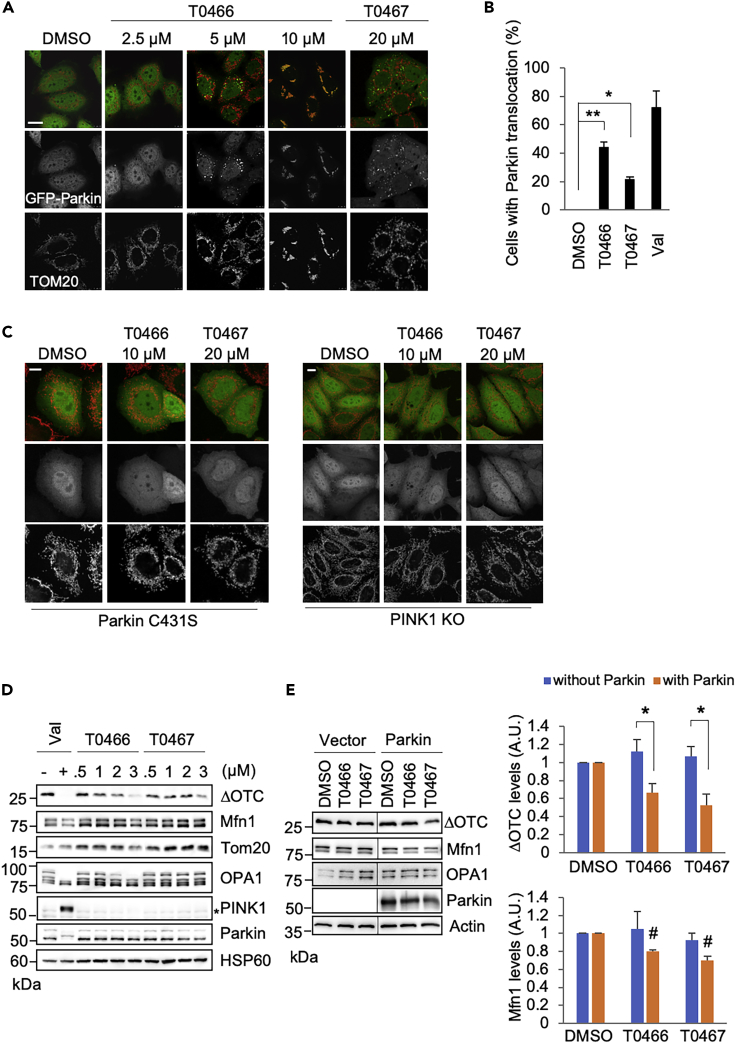
T0466 and T0467 Activate Parkin, Which Reduces an Unfolded Mitochondrial Protein(A) T0466 and T0467 stimulate mitochondrial translocation of Parkin in HeLa cells. HeLa/GFP-Parkin cells were treated with the cpds at the indicated concentrations for 3 h. DMSO treatment served as a mock control. Mitochondria were visualized with anti-TOM20 staining. Scale bar, 20 μm.(B) Mitochondrial translocation efficiency of Parkin by the cpds. HeLa/GFP-Parkin cells were treated with 5 μM T0466 and 20 μM T0467 for 3 h. The graph (mean ± SEM, n = 3 biological replicates) represents the percentage of cells with GFP-Parkin colocalized with TOM20. Cells treated with a mitochondrial uncoupling reagent Val (10 μM) served as the positive control. ∗p < 0.005, ∗∗p < 0.0001 versus DMSO using Dunnett's test.(C) Parkin mitochondrial translocation by T0466 and T0467 is Parkin E3 activity- and PINK1-dependent. HeLa cells transfected with an E3 dead form of GFP-Parkin C431S (left) and PINK1-deficient HeLa cells (right, PINK1 KO) were treated with T0466 or T0467 as in (A). Scale bars, 25 μm.(D) Unfolded mitochondrial protein (ΔOTC) is reduced by T0466 and T0467. ΔOTC/HeLa-TetOn cells with the stable expression of YFP-Parkin were treated with doxycycline (DOX, 1 μg/mL) for 72 h to induce mitochondrial ΔOTC expression. After removal of DOX, cells were treated with the indicated concentration of drugs for 8 h. Asterisk, non-specific.(E) T0466 and T0467 promote ΔOTC degradation in the presence of Parkin. ΔOTC/HeLa-TetOn cells transfected with a mock vector or Parkin were treated with DOX (1 μg/mL) for 24 h. After removal of DOX, cells were treated with 2 μM T0466 or 3 μM T0467 for 8 h. The relative band intensities of ΔOTC in 0.5% Triton X-100-insoluble fraction normalized with actin and of Mfn1 normalized with tubulin in 0.5% Triton X-100-soluble fraction are represented here (mean ± SEM, n = 4 biological replicates). ∗p < 0.05 by two-tailed Student's t test; #p < 0.01 versus DMSO with Parkin using Dunnett's test.See also Figures S2 and S3.